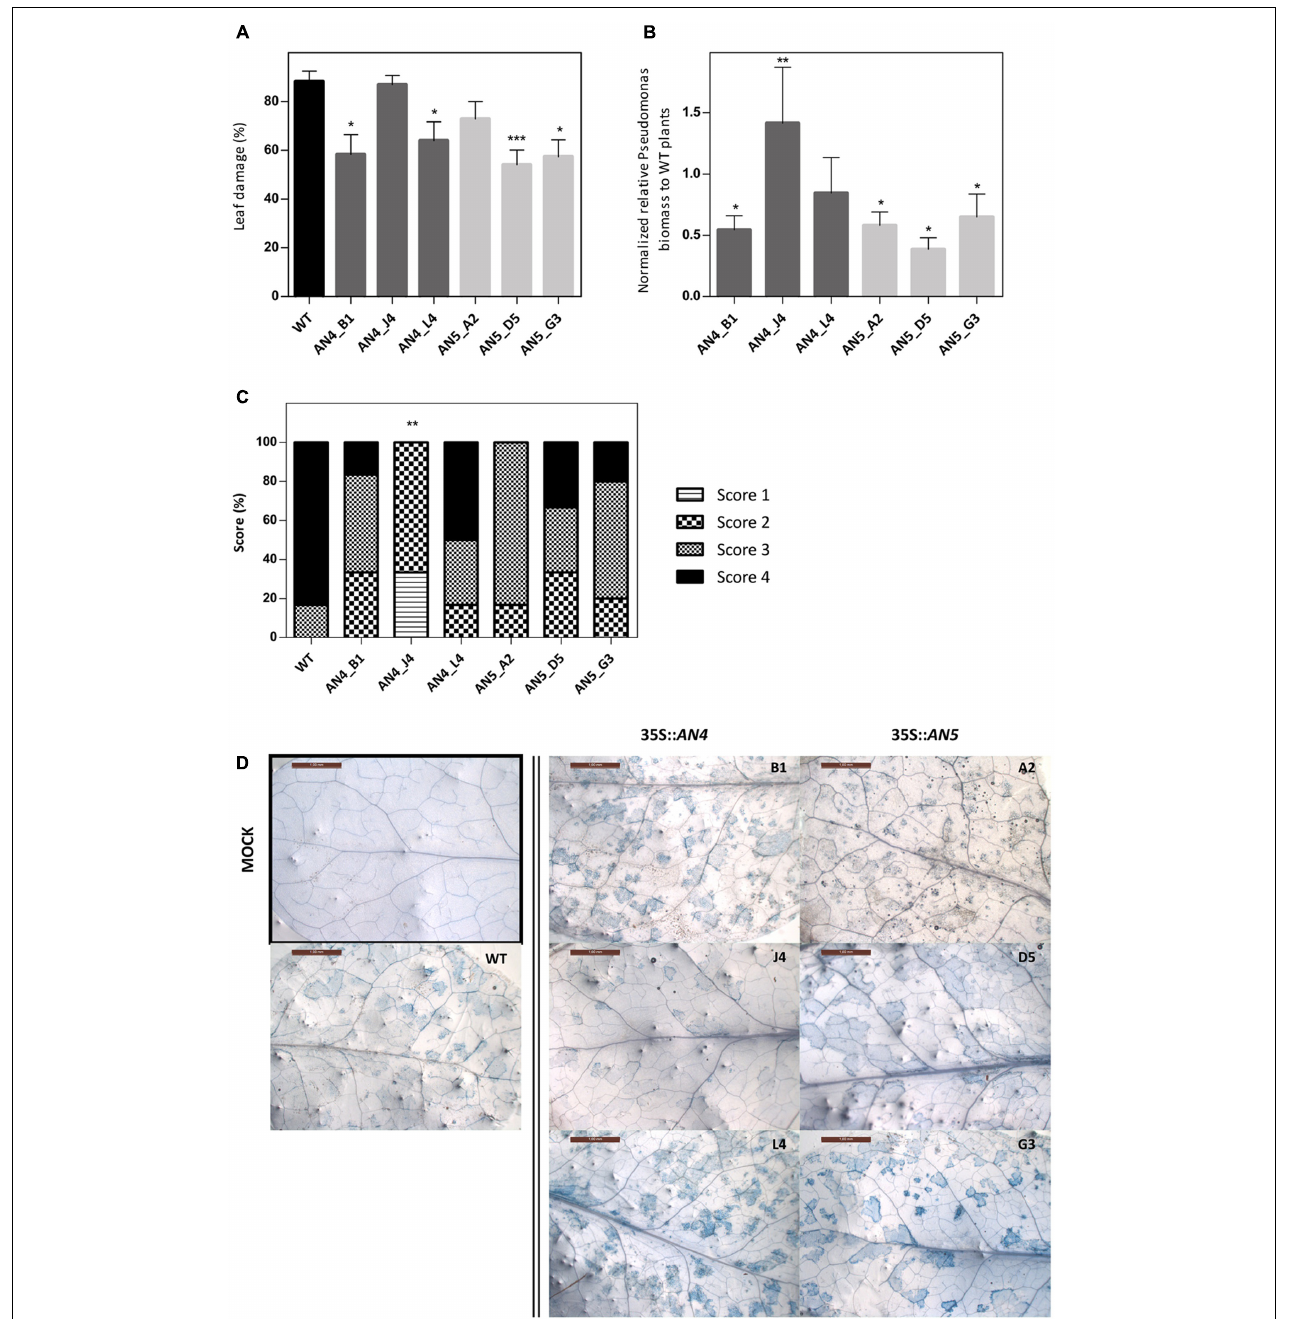
FIGURE 8 | (A) Percentage of leaf damage in WT and transgenic overexpression A. thaliana plants infected with P. syringae at 4 dpi. (B) Normalized relative P. syringae biomass in the overexpression lines compared to WT plants at 4 dpi. (C) Scoring of trypan blue stained leaves (D) from overexpression lines compared to WT plants at 4 dpi. (A) Percentage of leaf damage calculated with Assess 2.0 at 4 dpi as percent ratio of yellow lesion area relative to the total leaf area. Bars represent the mean ± SE of two independent biological replicates with six individual leaves per line per replicate. Asterisks indicate statistically significant differences to the percentage of leaf damage in WT plants ( ∗ p ≤ 0.05, ∗∗ p ≤ 0.01, ∗∗∗ p ≤ 0.001; Mann–Whitney U test). (B) Bars represent the mean ± SE relative P. syringae biomass in overexpression lines to biomass in WT plants at 4 dpi from two independent biological replicates normalized with two A. thaliana reference genes ( ACT2 and PEX4 ) in REST-384. Asterisks indicate statistically significant differences to the biomass in WT plants ( ∗ p ≤ 0.05, ∗∗ p ≤ 0.01, ∗∗∗ p ≤ 0.001; pair wise fixed reallocation randomization test REST-384). (C) Bars represent the scores in percentage from two independent biological replicates ( N = 2) with each time three leaves stained per line. Score 1: 0%, score 2: 1–30%, score 3: 31–60% and score 4: 61–100% trypan blue staining or cell death. Asterisks indicate statistically significant differences to the trypan blue staining in WT plants ( ∗ p ≤ 0.05, ∗∗ p ≤ 0.01, ∗∗∗ p ≤ 0.001; Mann–Whitney U test). (D) Representative pictures are shown for each transgenic line. Only one picture of a mock treated leaf is shown (black